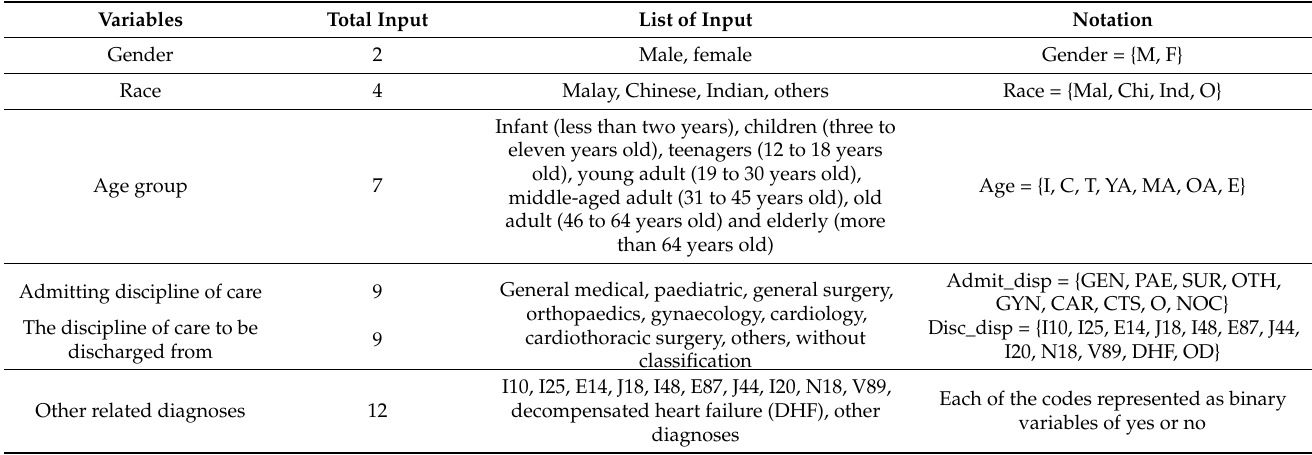
Table 2. Summary of variables and list of input used to create